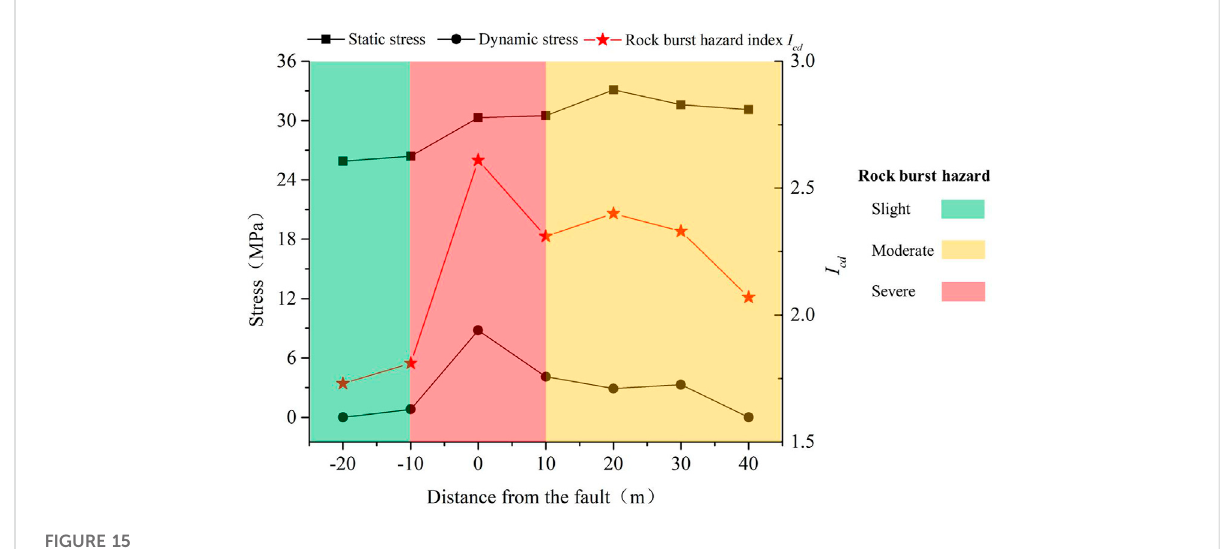
FIGURE 15 Classi fi cation of rock burst